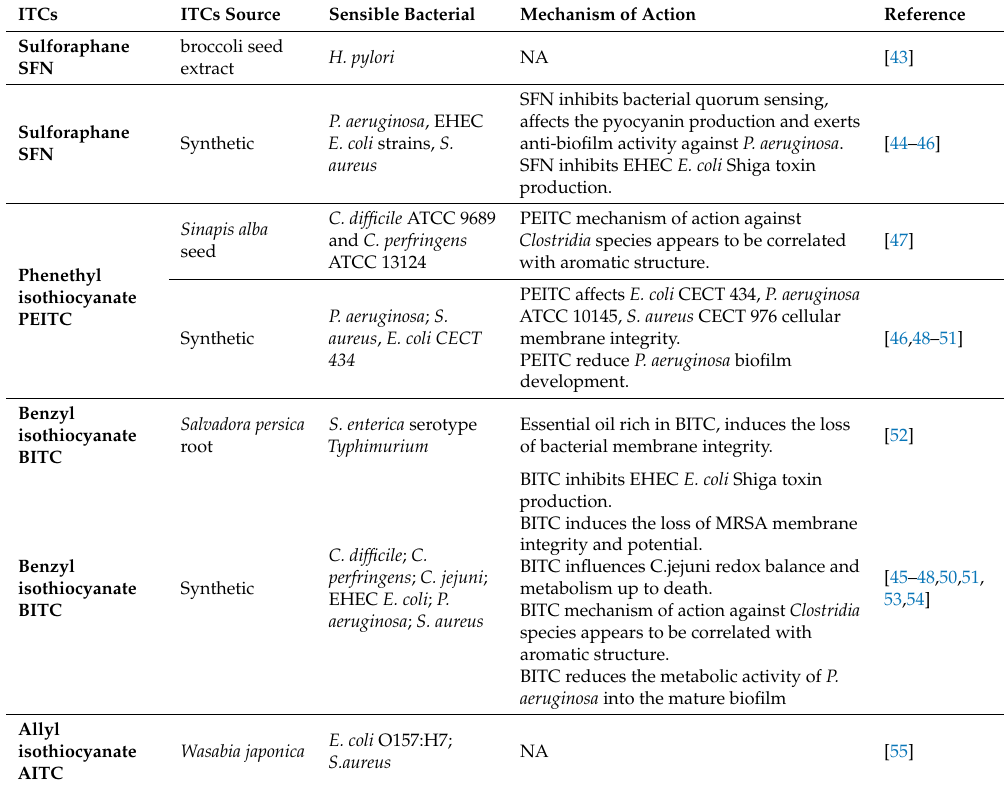
Table 2. Major ITCs showing antibacterial activity and mechanism of